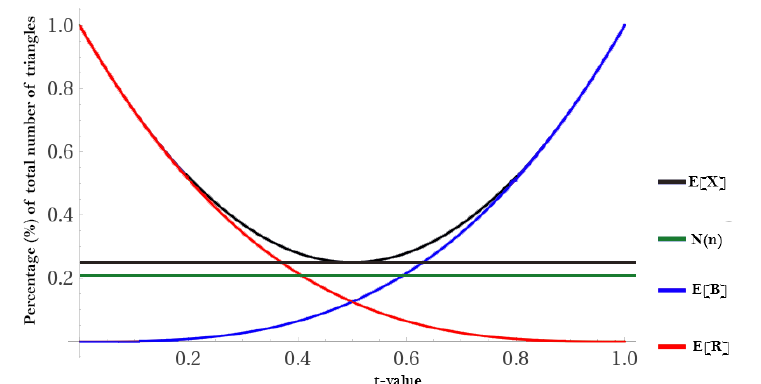
Figure 6. An example of a G ( N , t ) using N =